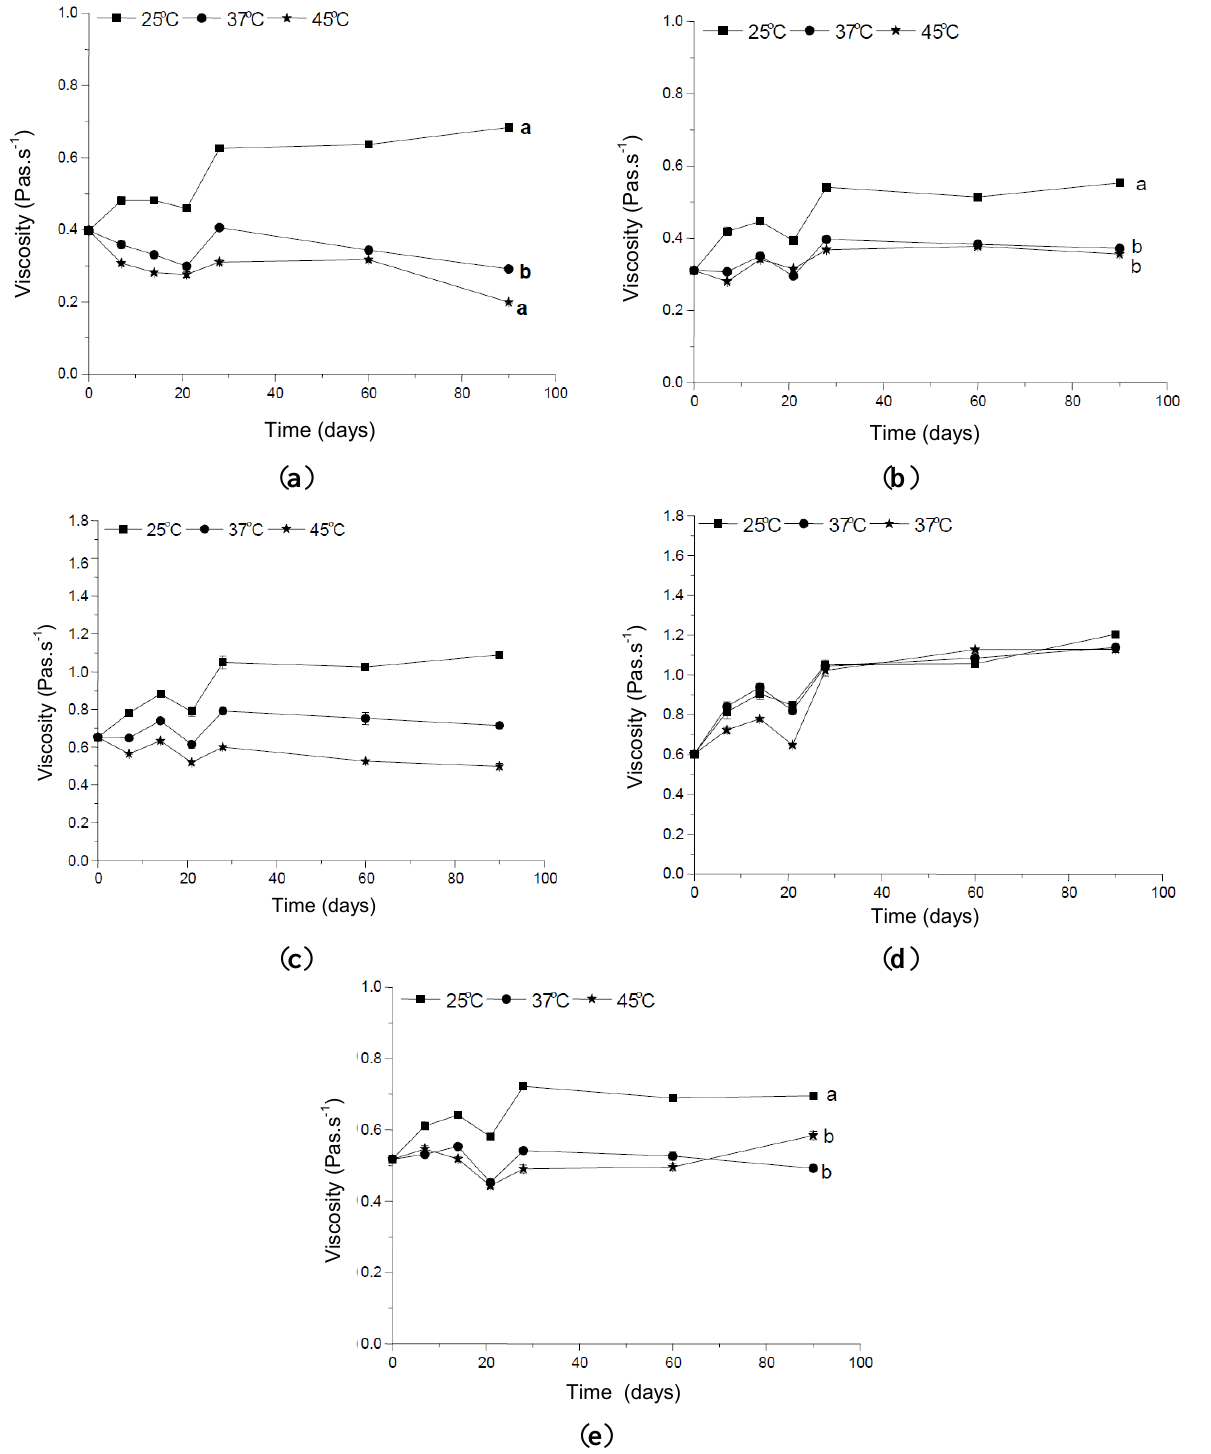
Figure 3. Changes in the viscosity versus storage times at different temperatures of the formulations: ( a ) vehicle; ( b ) containing the organic UV filters only, ( c ) supplemented with CePO , ( d ) supplemented with TiO , and ( e ) supplemented with 4 2